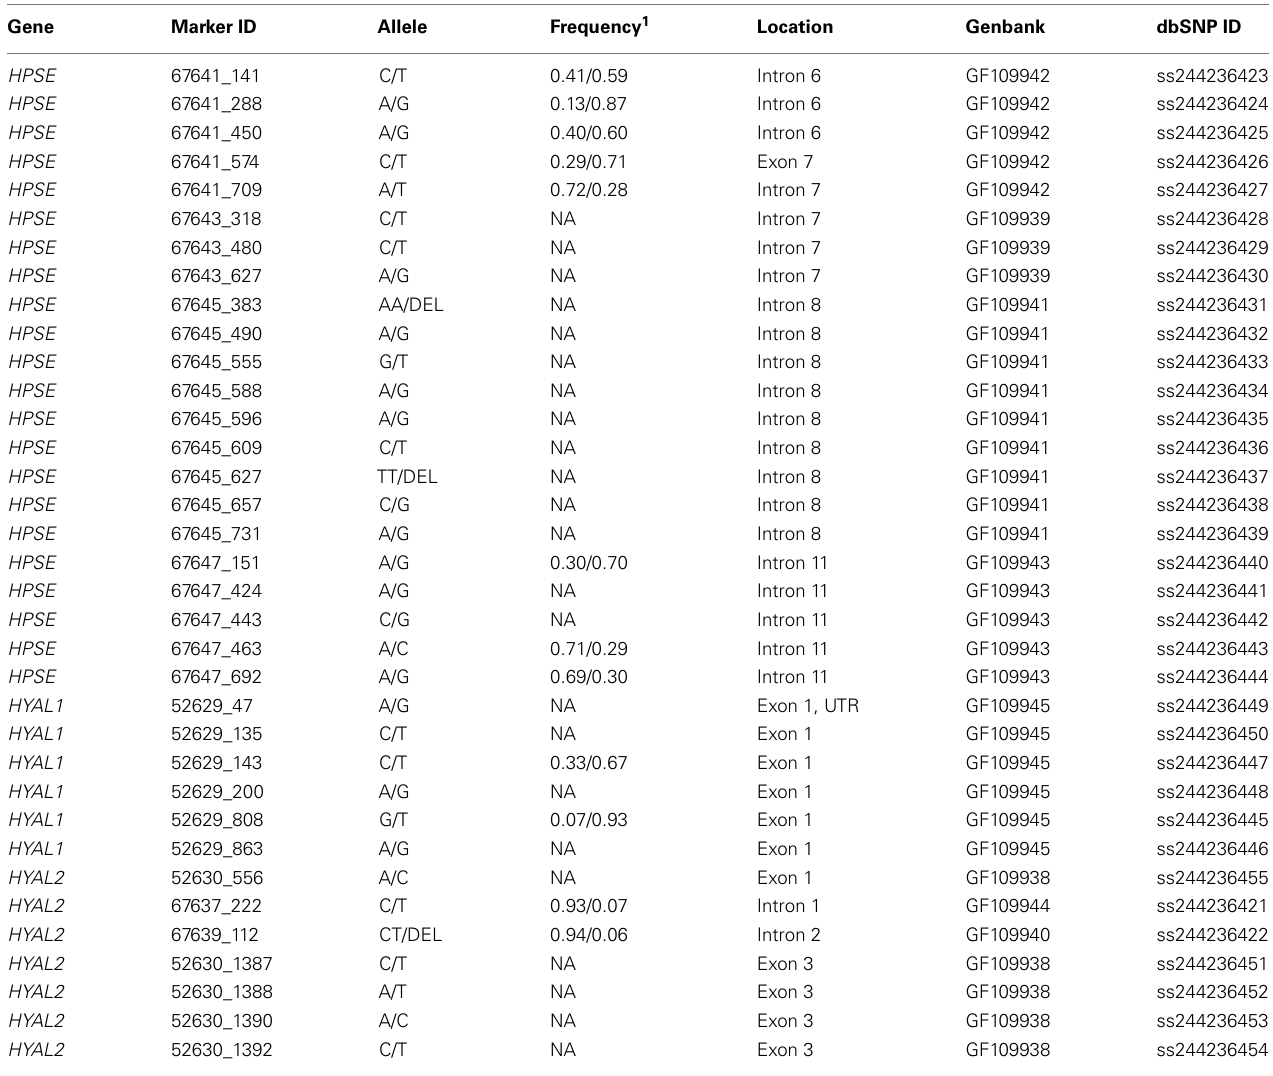
Table 2 | SNPs identified from